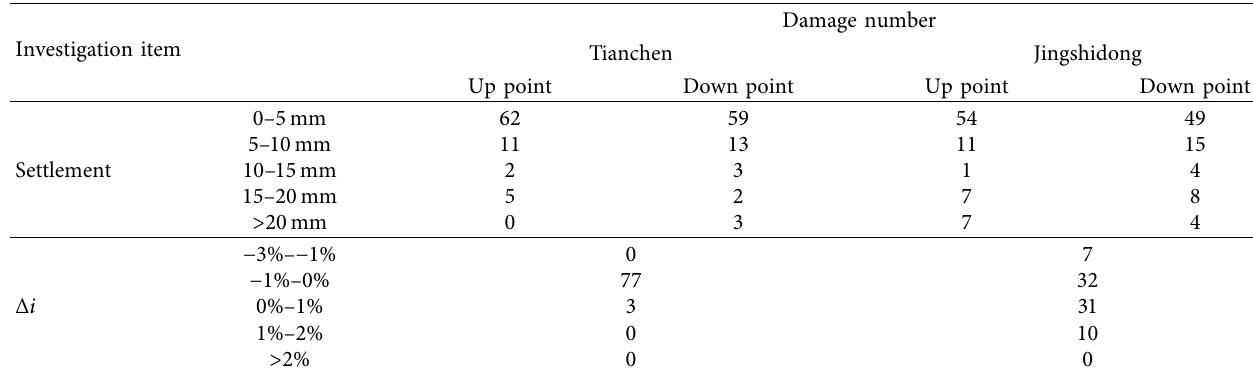
Table 2: Settlement of manholes and changes of road longitudinal slope.